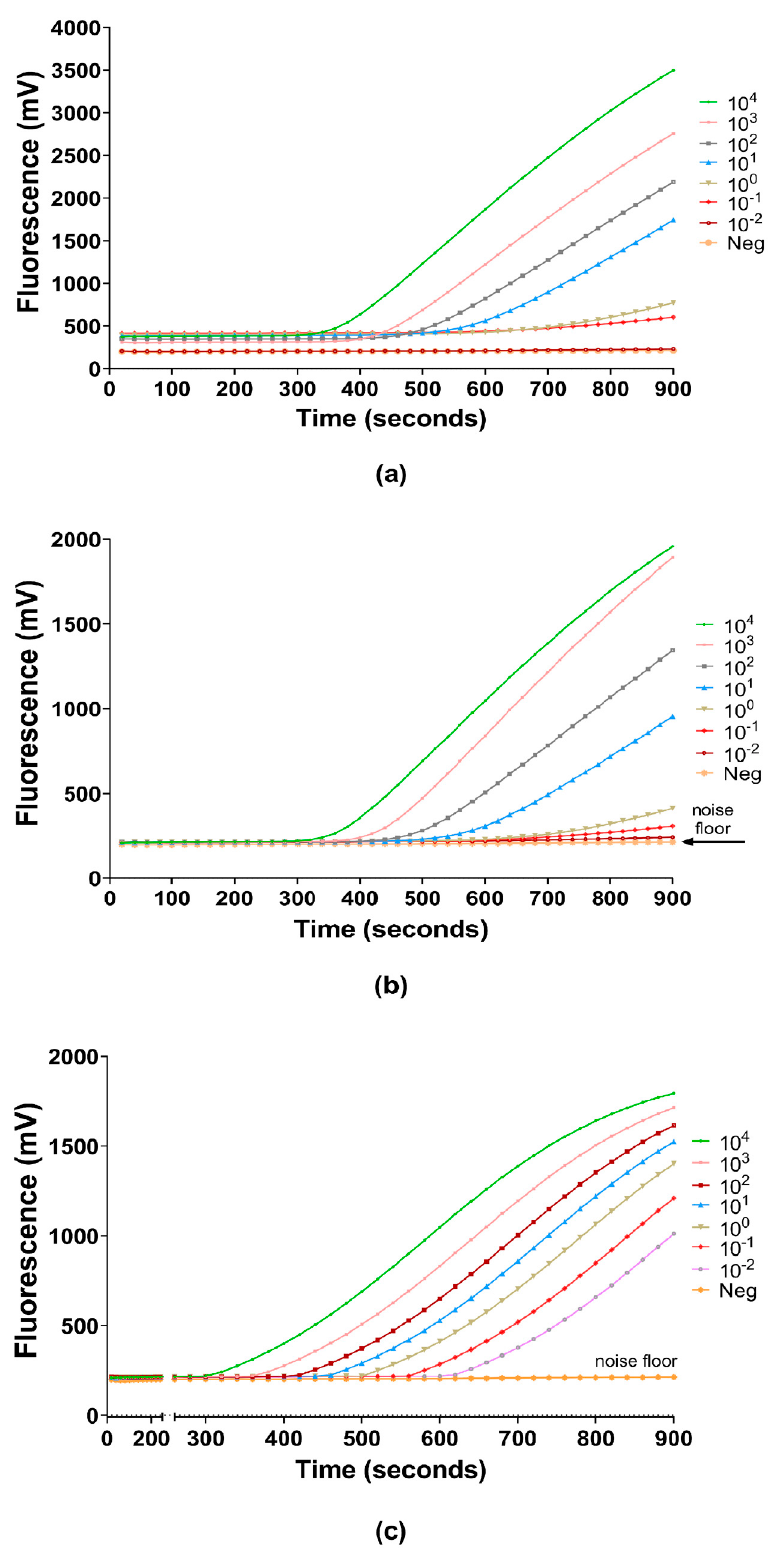
Figure 1. RPA amplification curves of NFW dilution series (10 4 to 10 − 2 genome/reaction) in terms of relative fluorescence acquisition in a 15 min (900 s) run protocol. Plots were generated by using ( a ) machine read data; ( b ) normalized data; ( c ) transformed data to generalize the amplification.